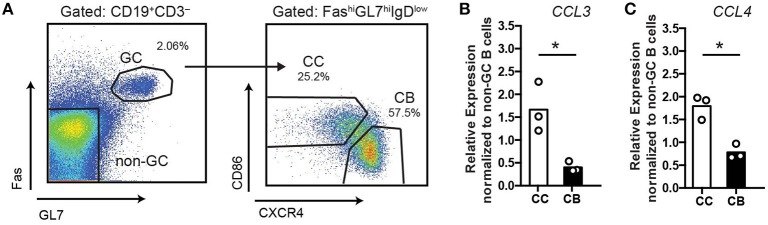
Upregulation of CCL3/4 expression in GC centrocytes. qRT-PCR analysis of CCL3 and CCL4 expression in GC and non-GC B cells sorted from the draining LNs of mice s.c. immunized with 50 μg ovalbumin (OVA) in Ribi at 10 days post-immunization (d.p.i). (A) The gating strategy for cell sorting. (B,C) Relative expression of CCL3/4 in bulk GC centroblasts (CB) and centrocytes (CC) as normalized to non-GC B cells (FASlow GL7low). Chemokine CT values were normalized to β2m CT. Bars represent mean with dots representing average values per experiment. Data represent n = 3 independent experiments, 4 mice total. *P < 0.05, two-tailed Student's t-test.